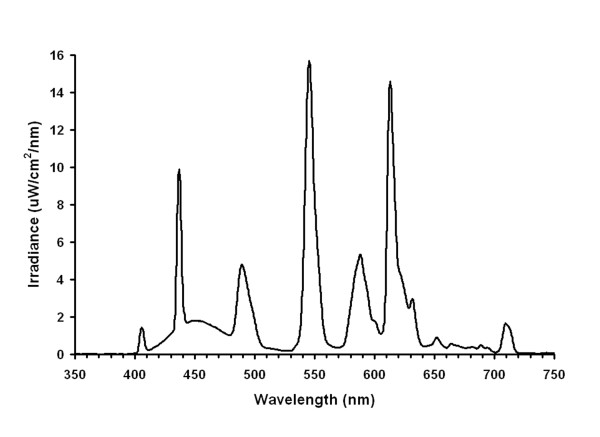
The light spectrum of the bright light treatment. The spectral content of the bright light treatment measured at eye level (standing) was averaged for the 3 subject rooms. The abscissa is wavelength in nanometers.